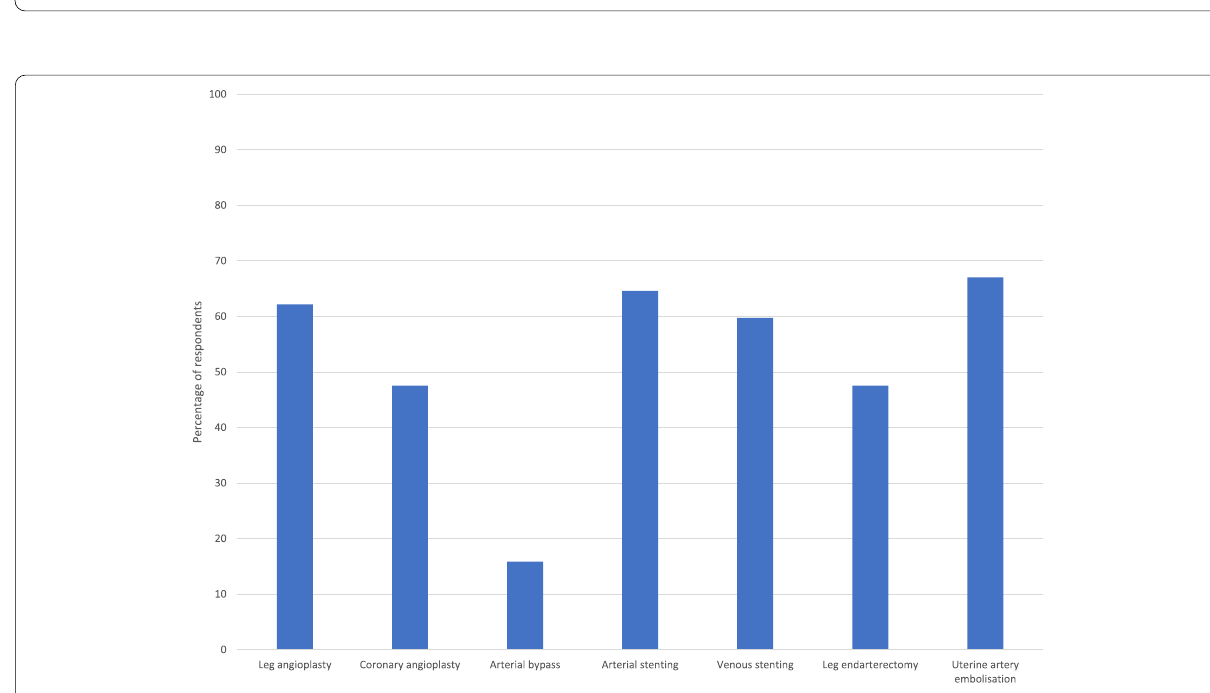
Fig. 4 Bar graph showing the current understanding of different procedures, some of which are performed by interventional